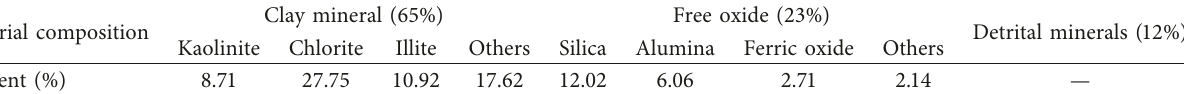
Table 2: Material composition of red clay.